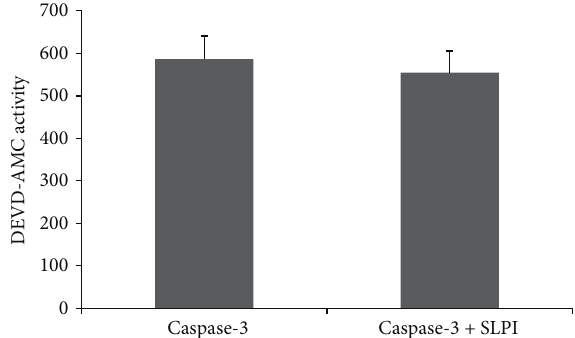
Figure 5: Effect of SLPI on recombinant caspase-3 activity. SLPI (100ng) was pretreated for 1hr with recombinant human caspase- 3 (10ng). Caspase-3 activity was measured using the fluorogenic substrate DEVD-AMC. Results are representative of 𝑛 = 5